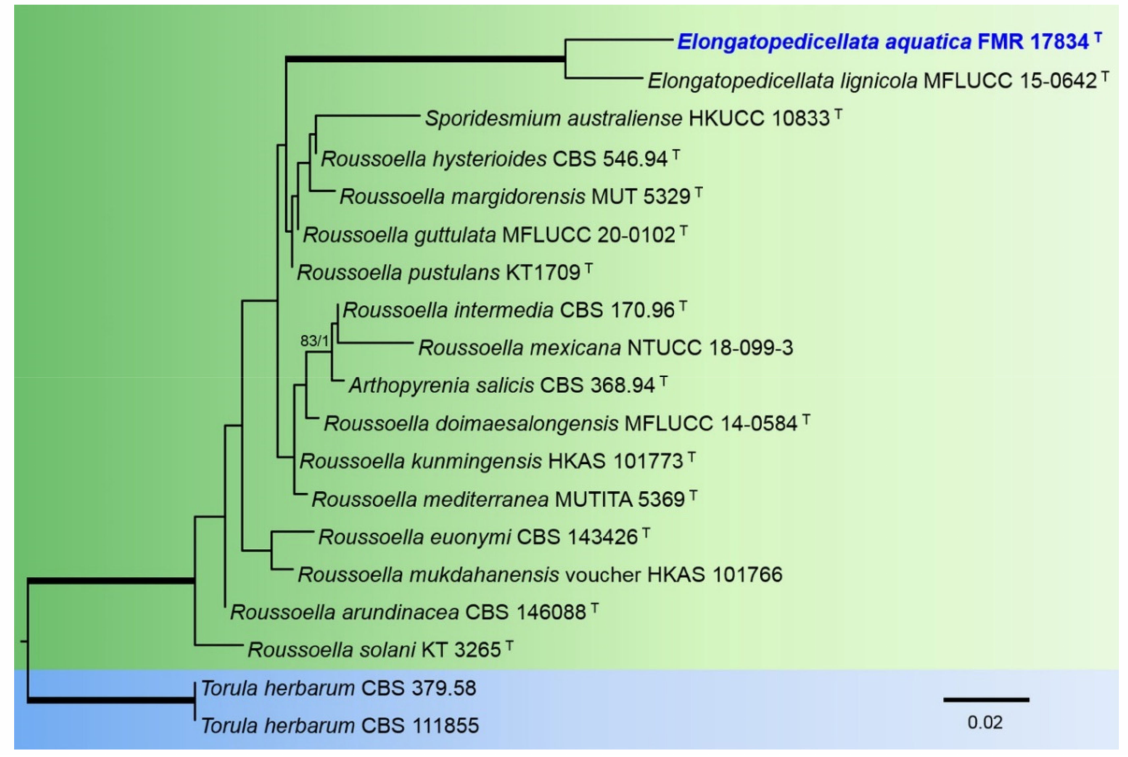
Figure 4. Phylogenetic tree inferred from an ML analysis inferred from LSU sequences of 18 strains representing species in the Roussoellaceae . The RAxML bootstrap support values (BS) above 70% and the Bayesian posterior probabilities (PP) above 0.95 are given at the nodes (BS/PP). Fully supported branches (100 BS/1 PP) are indicated in thicker lines. Newly proposed taxa are given in blue . Type strains are indicated by a superscript “T”. The tree was rooted with Torula herbarum CBS 379.58 and CBS 111855. Alignment length 845